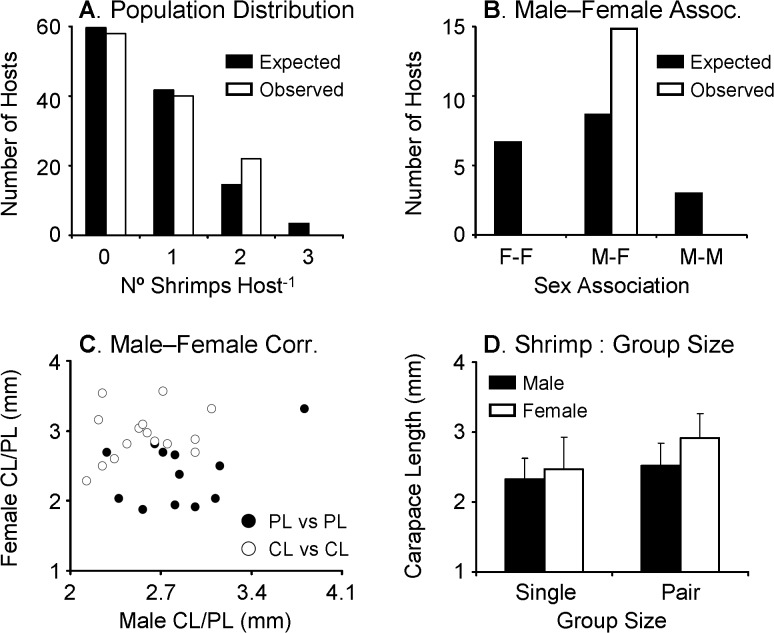
Host use pattern of Odontonia katoi (combined data from different sampling locations) at Kimbe Bay, Papua New Guinea.(A) Population distribution of O. katoi. Observed frequency of shrimps on hosts did not differ significantly from an expected Poisson random distribution. (B) Male-female association pattern of O. katoi found as pairs inside the atrial chamber of Polycarpa aurata. Observed frequency of heterosexual pairs differs significantly from the expected binomial random distribution. (C) Relationship between carapace length (CL) and cheliped length (PL) of males and females of O. katoi found as heterosexual pairs inside the atrial chamber of P. aurata. (D) Carapace length (mean and standard deviation [bars]) of male and female shrimps occurring either solitarily or in pairs inside the atrial chamber of Polycarpa aurata. Males and females were smaller when found solitarily compared to when found in pairs. See results for further details.